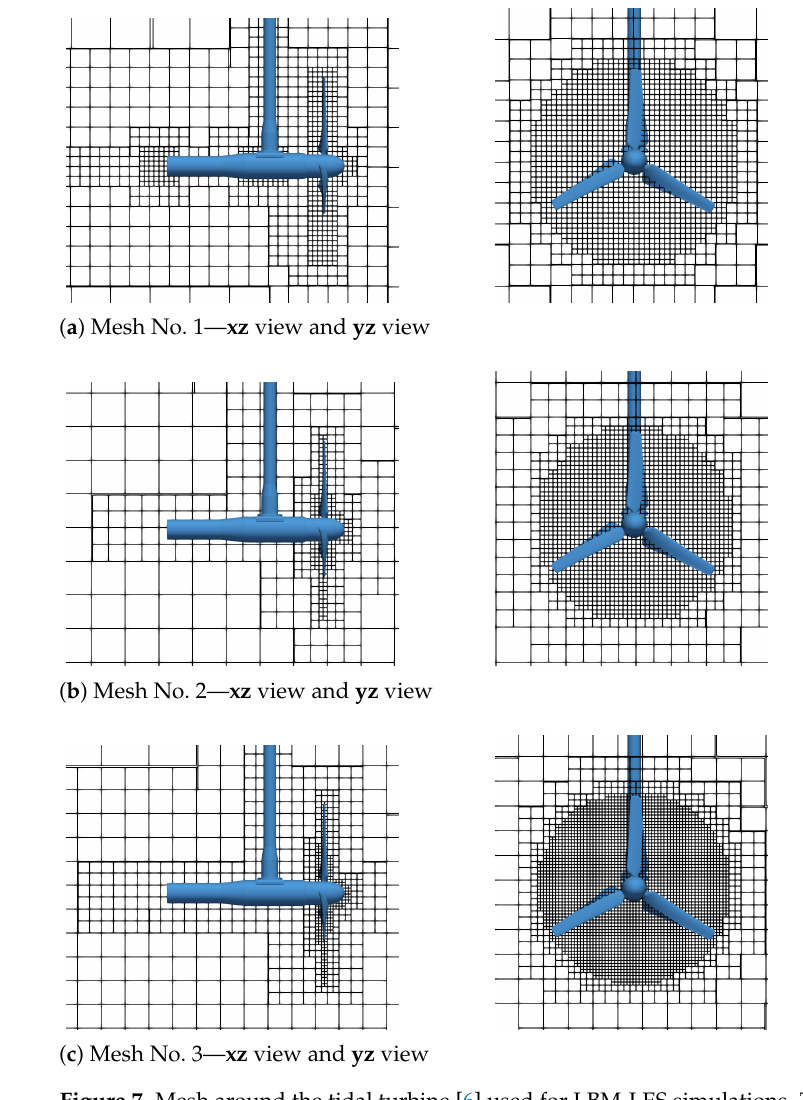
Figure 7. Mesh around the tidal turbine [6] used for LBM-LES simulations. The domain is centred at the rotor centre. ( a ): mesh No. 1 is represented in cubes of 14 × 14 × 14 nodes. ( b , c ): mesh No. 2 and 3 are represented in cubes of 16 × 16 × 16